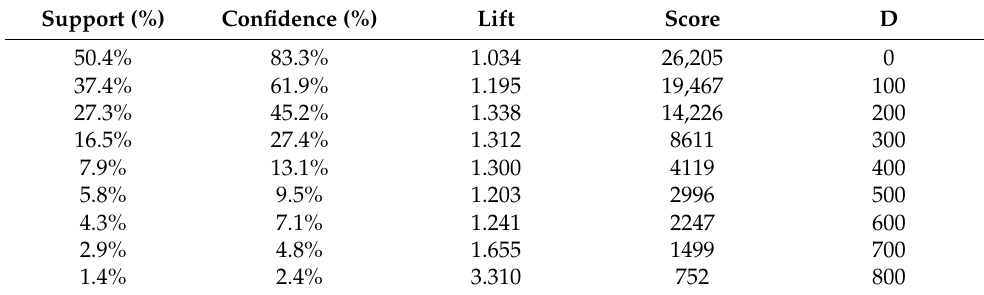
Table 7. Parameters of the rule with A-E-K body calculated for several thresholds of delay. Support (%) Confidence (%) Lift Score D 50.4% 83.3% 1.034 37.4% 27.3%